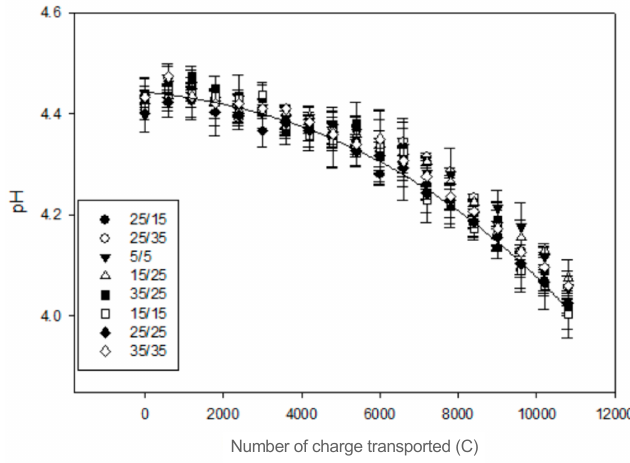
Figure 4. Acid whey pH evolution in the AWComp for the eight PEF conditions tested.